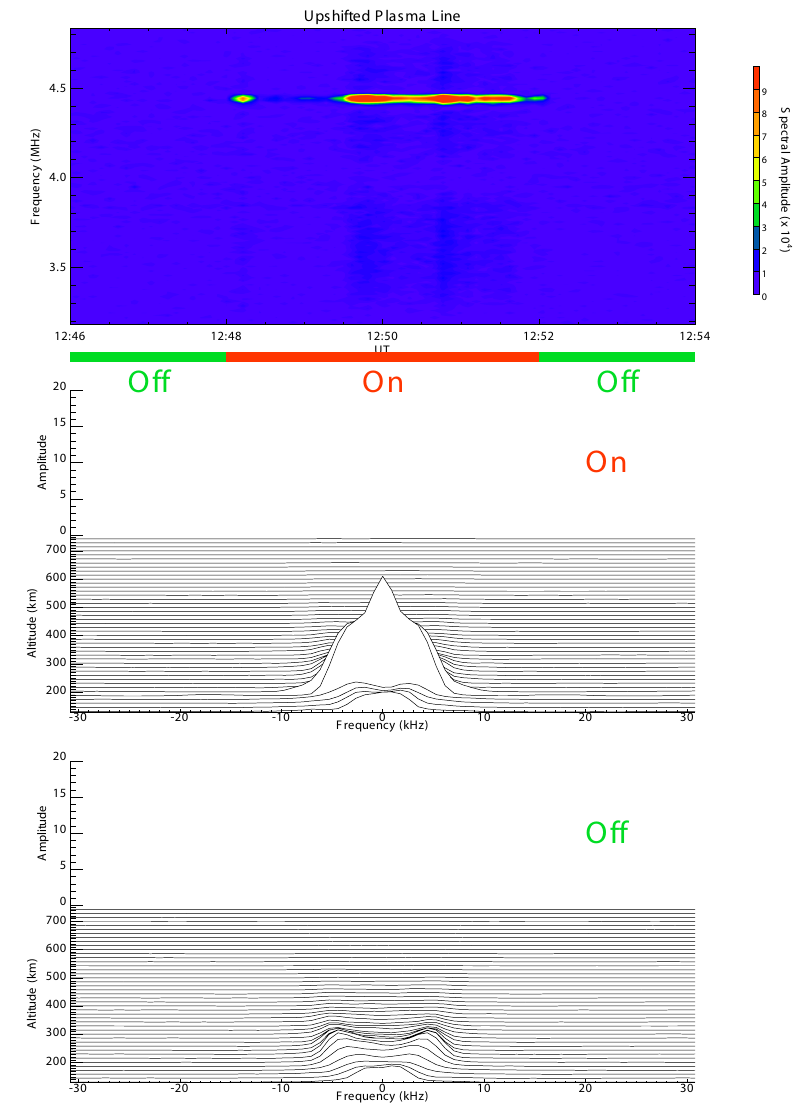
Fig. 12. ESR plasma-line is shown in the upper panel during 12:46–12:54 UT 1 October 2004, together with the average ion-line spectra for O-mode SPEAR-on (centre panel) and SPEAR-off (lower